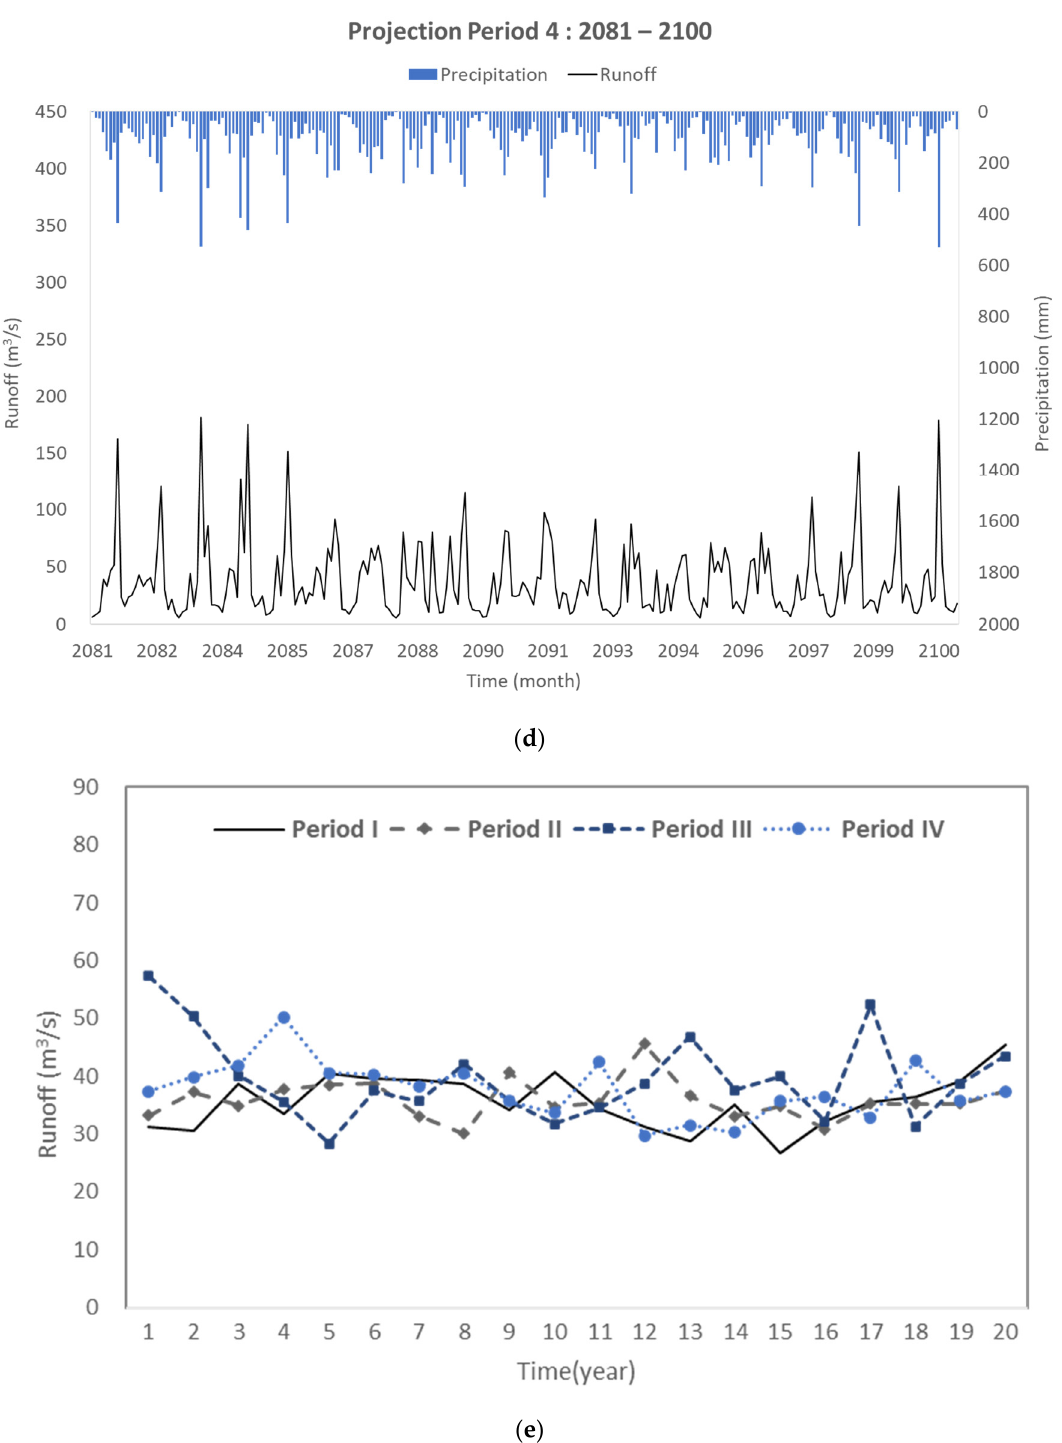
Figure 4. Future discharge simulation results of the Deoksong SHP plant basin. ( a ) Monthly average discharge: Period I (2021–2040), ( b ) monthly average discharge: Period II (2041–2060), ( c ) monthly average discharge: Period III (2061–2080),